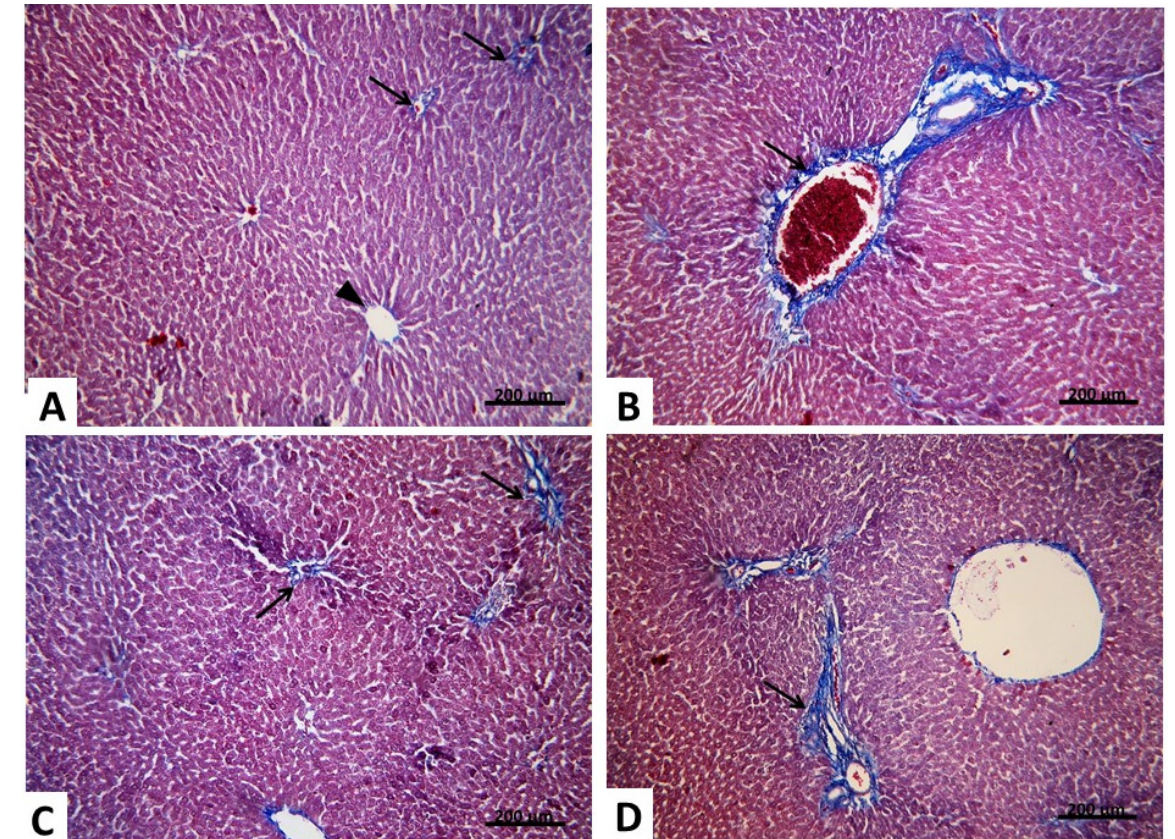
Figure 9. ( A ) Group I. Mallory’s trichrome stain ×250 showing a few collagen fibers ( ↑ ) in the portal tract, around the central vein ( ▲ ) and in between hepatocytes. ( B ) Group II Mallory’s trichrome stain ×250 showing an apparent increase in the amount of collagen fibers in the portal tract ( ↑ ) and around the central vein. ( C ) Group III. Mallory’s trichrome stain ×250 showing collagen fibers ( ↑ ) in the portal tract nearly similar to the control group. ( D ) Group IV Mallory’s trichrome stain ×250 showing an apparent decrease in the amount of collagen fibers ( ↑ ) in the portal tract and around the central vein.